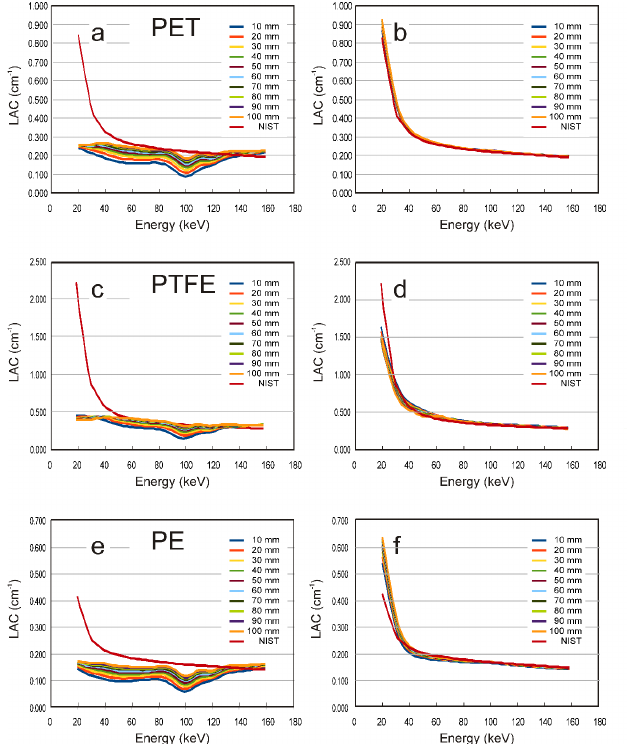
Figure A1. The experimentally determined LAC of Polyethylene terephthalate (PET) ( a ), Polyte- trafluoroethylene (PTFE) ( c ) and Polyethylene (PE) ( e ) and the same values after recalibration ( b , d , f ). For comparison the corresponding National Institute for Standards and Technology (NIST) certified values were plotted.